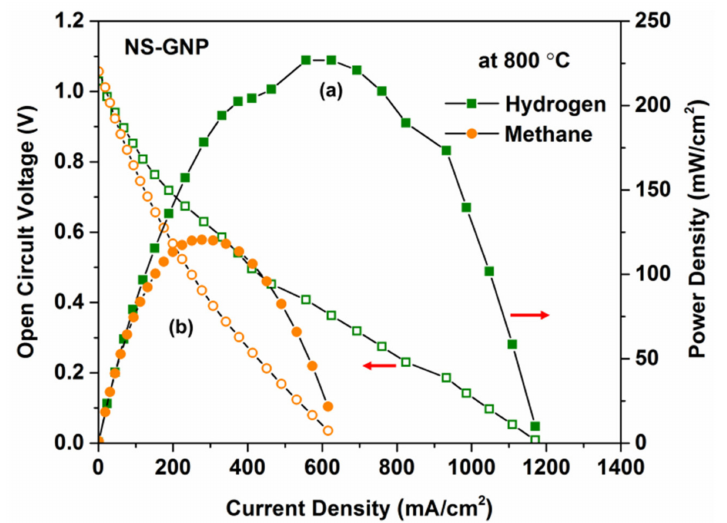
Figure 11. I–V and I–P characteristics of the electrolyte-supported single cells based upon on NS-GNP: ( a ) hydrogen and ( b )